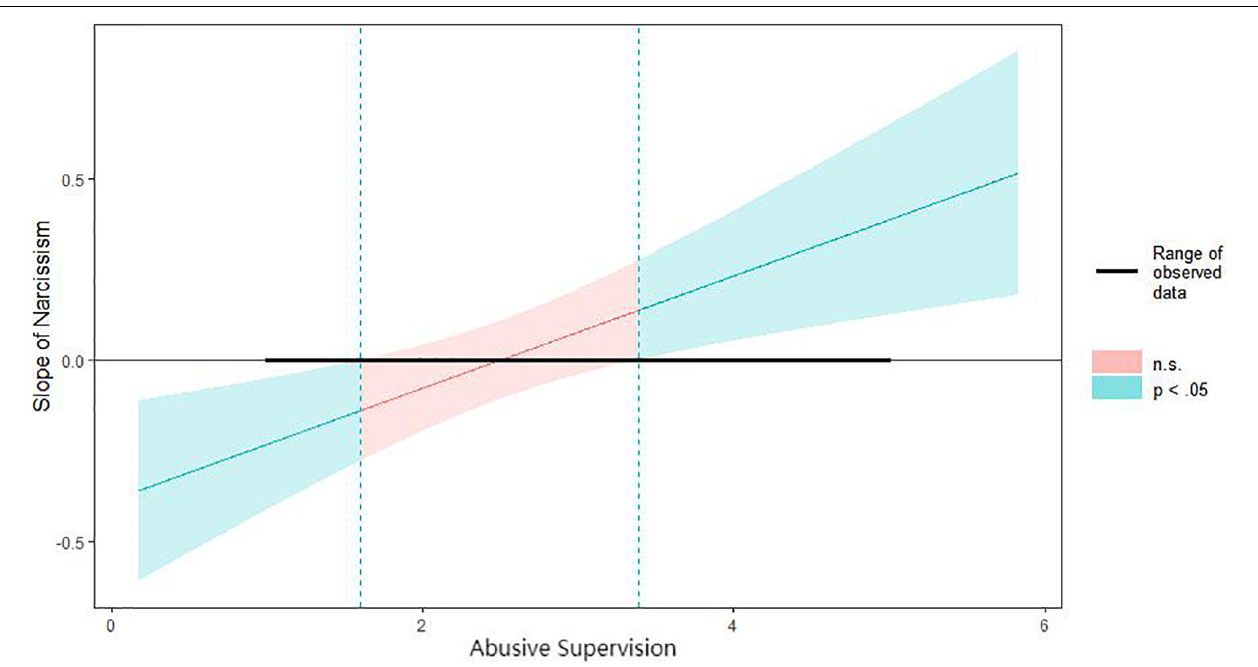
FIGURE 2 | Johnson-Neyman interaction plots for abusive supervision and